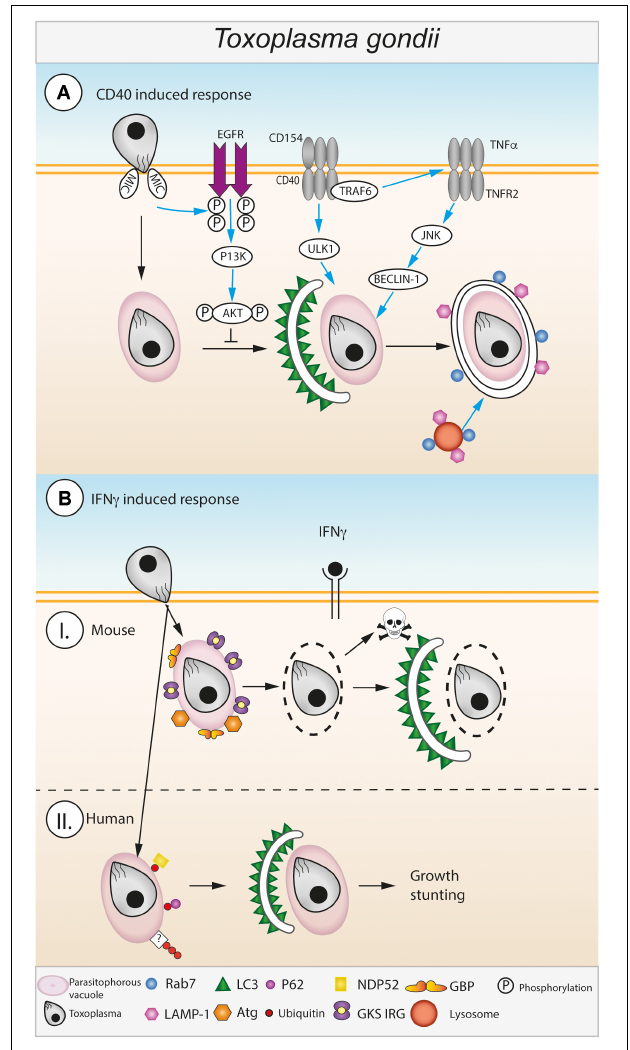
FIGURE 3 | Autophagic control of Toxoplasma gondii . (A) CD40 induced autophagy during Toxoplasma infection. Toxoplasma enters into host macrophages via an active invasion process, the parasite resides in the host cytosol within a parasitophorous vacuole (PV). Host autophagy pathways are induced against Toxoplasma via interactions between CD40 expressed on the cell surface of infected macrophages and CD4 + T cells expressing CD154 (Andrade et al., 2006). CD40/CD154 ligation leads to recruitment of TRAF6 to CD40 which triggers increased TNF α secretion (Mukundan et al., 2005; Subauste et al., 2007). CD40 mediated ULK1 activation and TNFR2 mediated JNK/Beclin-1 activation leads to the formation of a double membraned autophagosome around the Toxoplasma PV (Andrade et al., 2005). The host’s autophagic response is actively inhibited by the Toxoplasma derived protein MIC which activates host EGFR which in turn activates PI3K leading to activation of the autophagy suppressor protein AKT (Muniz-Feliciano et al., 2013). Toxoplasma is destroyed by recruitment of Rab7 and LAMP1 and the subsequent fusion the PV with lysosomes (Andrade et al., 2006). The pathway depicted to the left of the dashed line is found in unstimulated and CD40-stimulated cells. (B) IFN γ induced autophagy during Toxoplasma infection. (I) In mouse cells stimulated with IFN γ the Toxoplasma PVM is disrupted by recruitment of GKS-motif containing Immunity Related GTPases (GKS IRG) and Guanylate Binding Proteins (GBPs) to the outer surface of the PVM (Degrandi et al., 2007; Virreira Winter et al.,